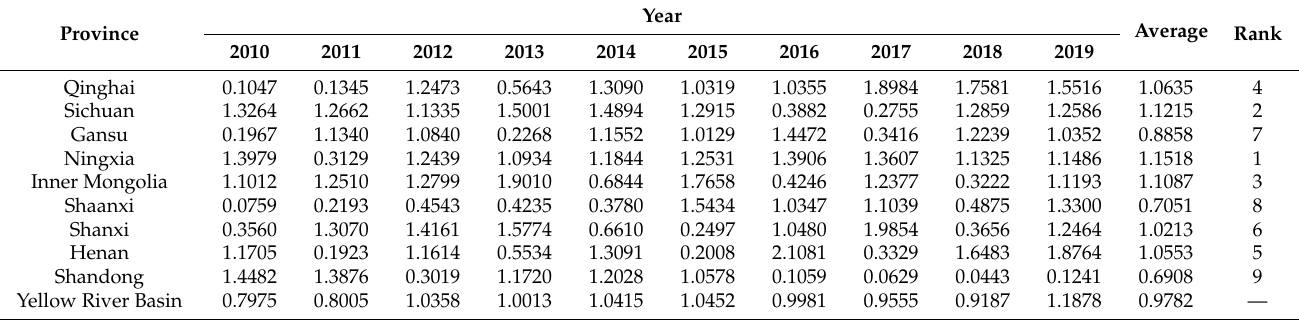
Table 3. Tourism’s carbon emission efficiency (TCEE) in the nine provinces in the Yellow River Basin.